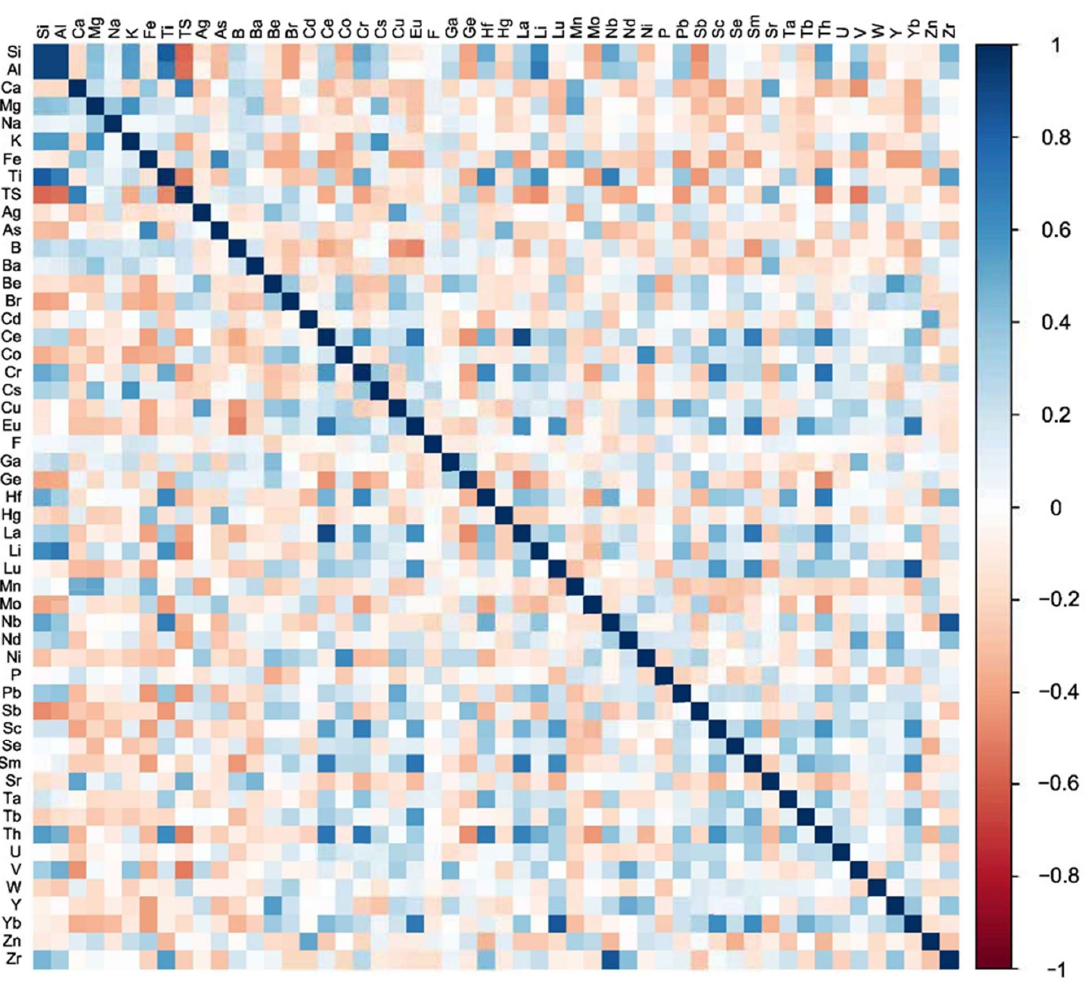
Figure 5. Matrix correlation coefficients represented by a color scale. White represents a correlation coefficient of zero, while darker blues represent stronger positive correlations, and darker reds represent stronger negative correlations.